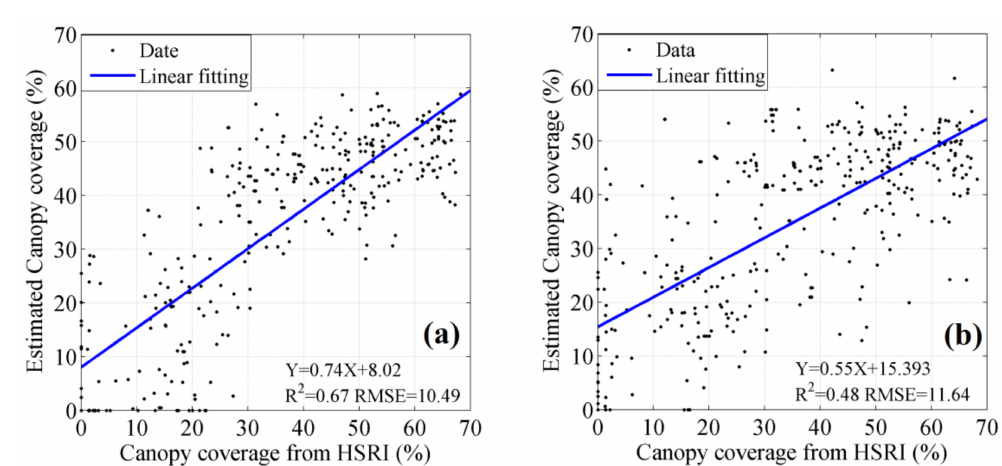
Figure 10. Validation of estimation models of forest canopy coverage: ( a ) model_2015 and ( b )